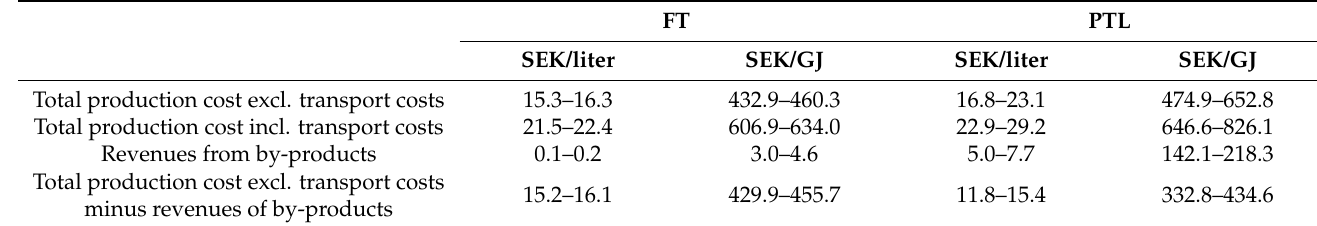
Table 10. Production costs per unit jet fuel output in 2025–2050. FT PTL SEK/liter SEK/GJ